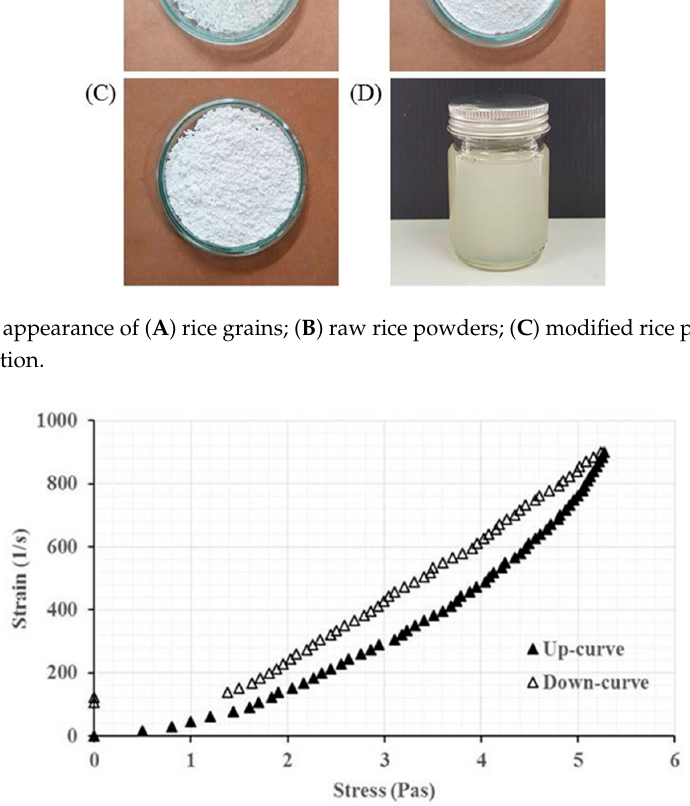
Figure 2. Rheogram of the modified rice gel containing 5% v / v lactic acid (LA-RG).